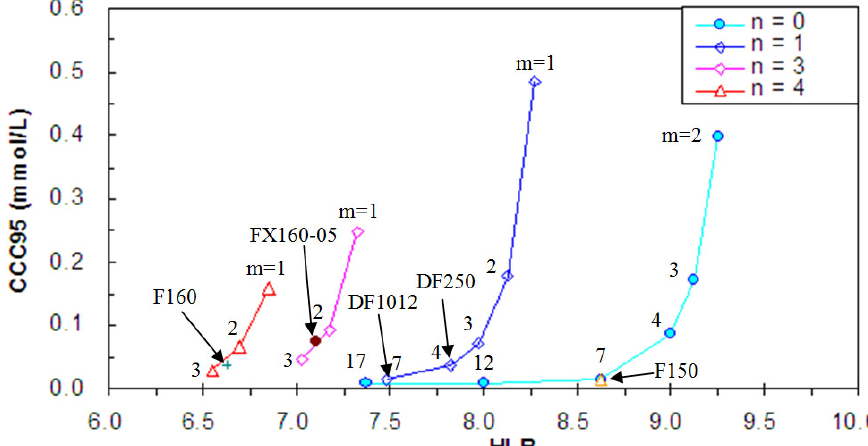
Figure 9. CCC95 versus HLB for the Polyglycols as function of m and